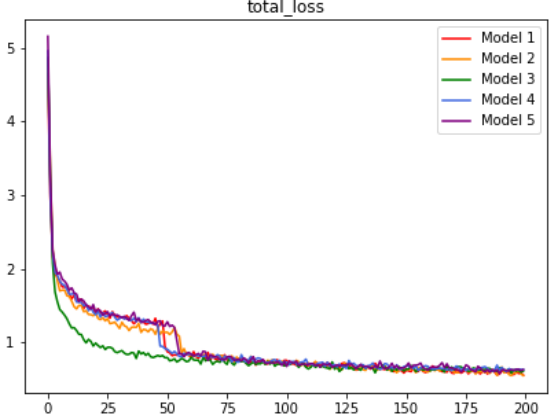
Figure 6. Total training loss of all models, where x-axis represents epoch time.